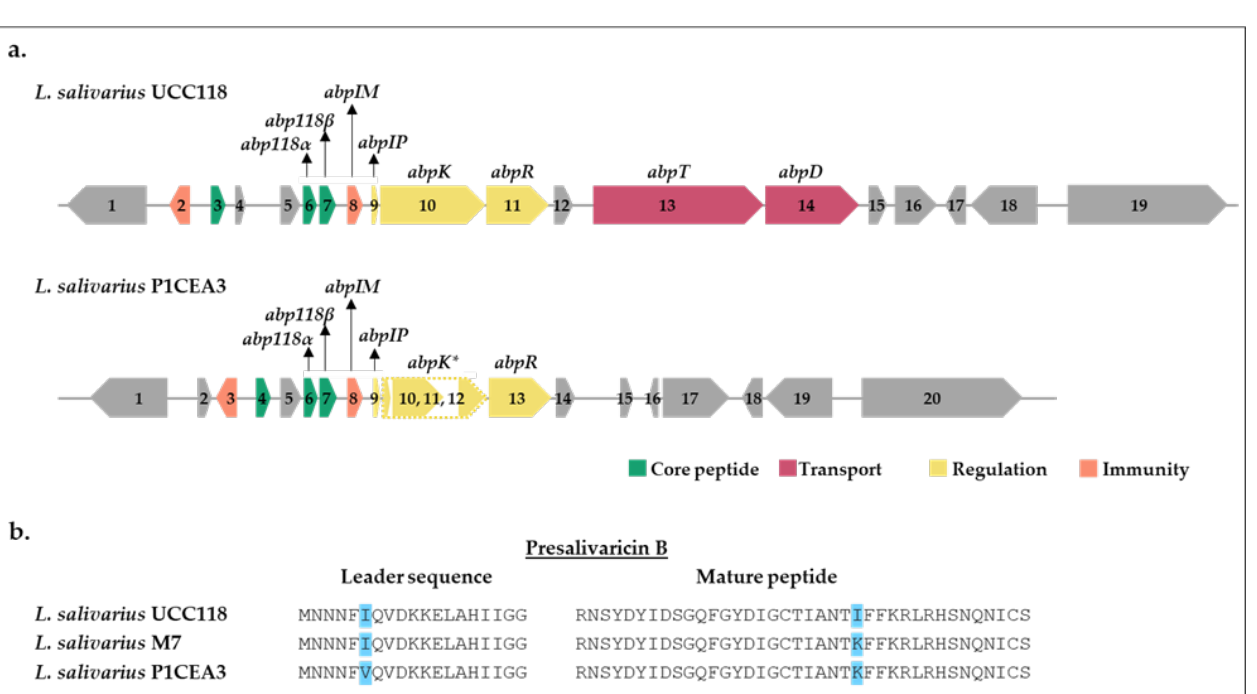
Figure 1. Comparison of the gene clusters from L. salivarius UCC118 and L. salivarius P1CEA3. ORFs are indicated by numbers and arrows, and those with a known function are indicated by gene identity and color. ( a ) ORFs 10–12 (so called abpK* ) code for a truncated version of AbpK from L. salivarius UCC118; ( b ) comparative alignment of the amino acid sequences of presalivaricin B in L. salivarius UCC118, L. salivarius M7, and L. salivarius P1CEA3. Amino acid differences are highlighted in blue.